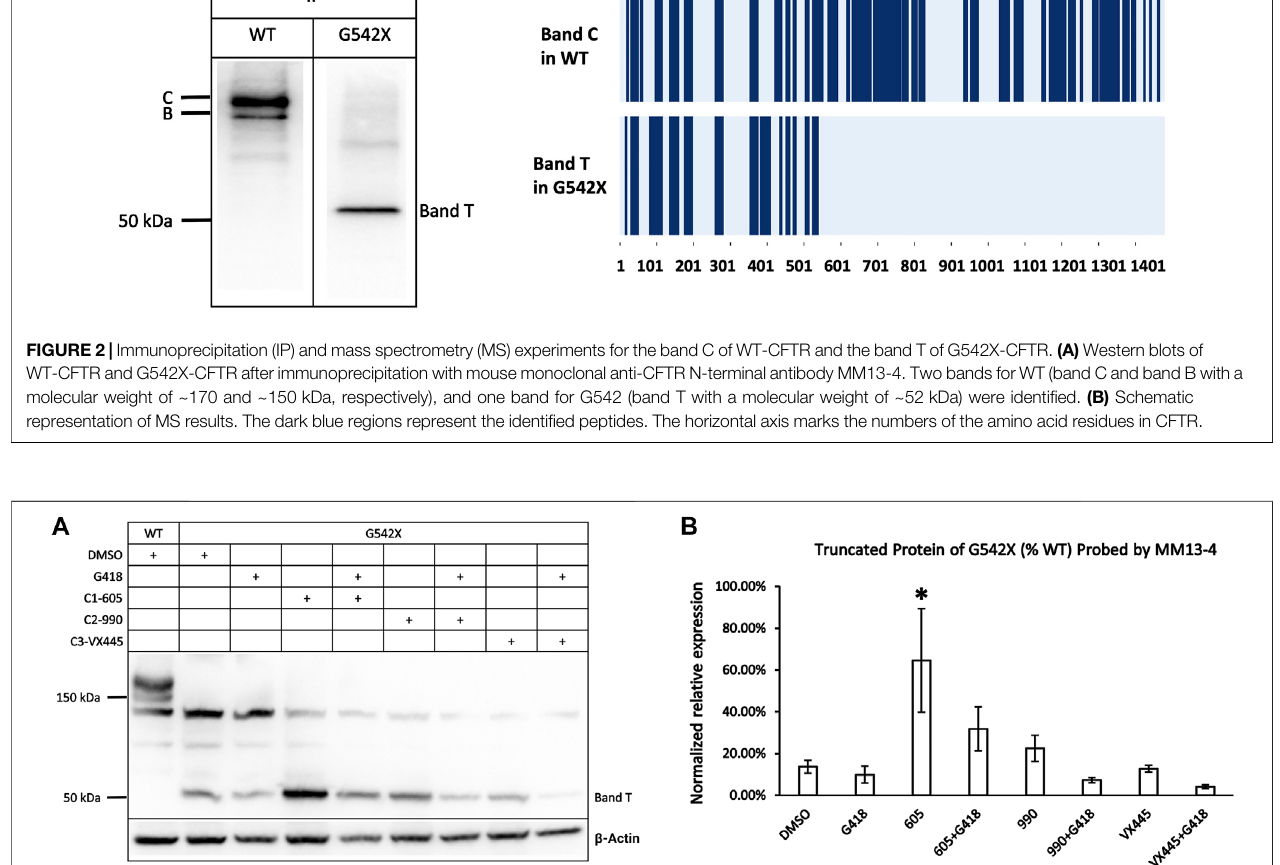
Frontiers in Molecular Biosciences |